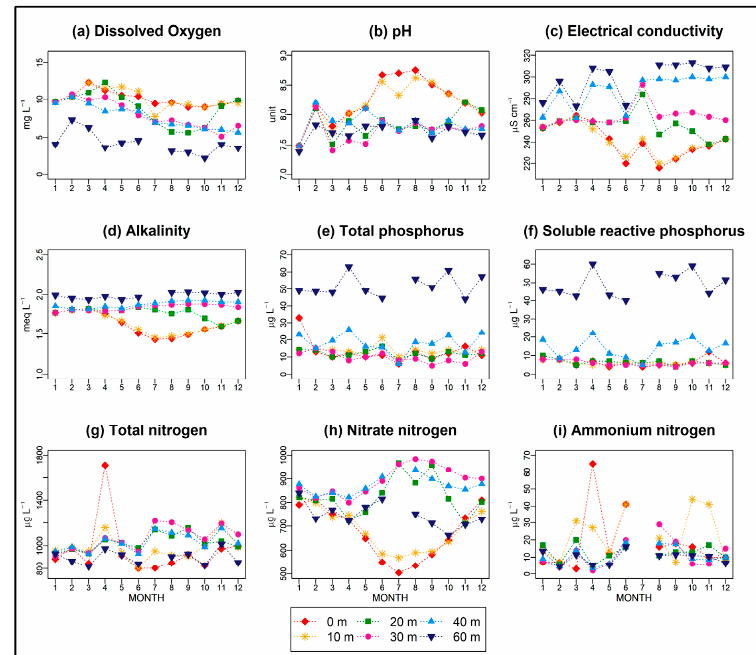
Figure 3. Temporal development of the principal chemico-physical features analyzed at six depths: ( a ) Dissolved oxygen, DO (mg/L); ( b ) pH; ( c ) Electrical conductivity, EC (µS/cm); ( d ) Alkalinity, ALK (meq/L); ( e ) Total phosphorus, TP (µg/L); ( f ) Soluble reactive phosphorus, SRP (µg/L); ( g ) Total nitrogen, TN (µg/L); ( h ) Nitrate nitrogen, NO 3 − (µg/L); ( i ) Ammonium nitrogen, NH 4+ (µg/L).